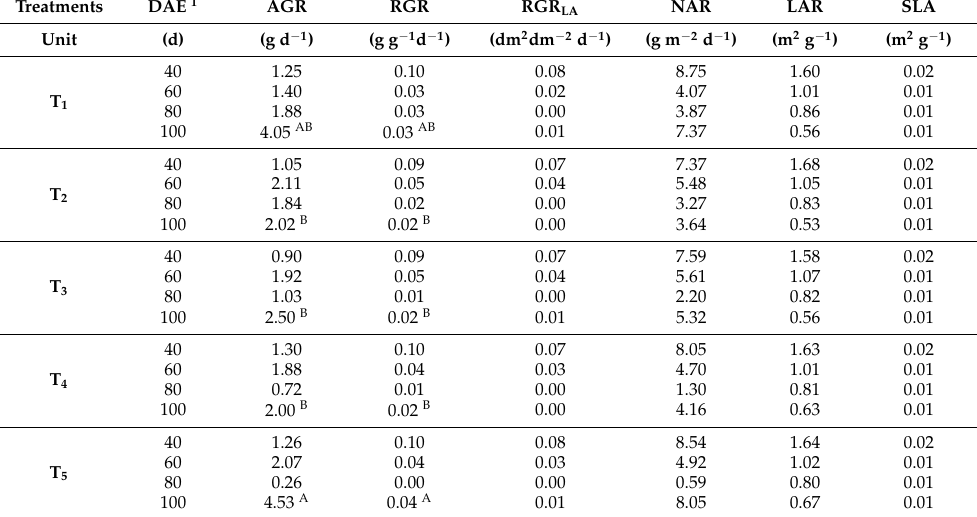
Table 8. Effect of fertilization treatments on the phytometric parameters of maize. T 1 = basal application of the digestate from swine wastewater as total substitute (100%) for synthetic N; T 2 = foliar application of the digestate as total substitute (100%) for synthetic N; T 3 = basal application of the digestate as partial substitute (50%) for synthetic N; T 4 = foliar application of the digestate as partial substitute (50%) for synthetic N; T 5 = in-row broadcast of mineral fertilizer. The treatments are fully described in Table 3. CV = coefficient of variation. DAE = days after emergency; AGR = absolute growth rate; RGR = relative growth rate; RGRLA = leaf area relative growth rate; NAR = net assimilation rate; LAR = leaf area ratio; SLA = specific leaf